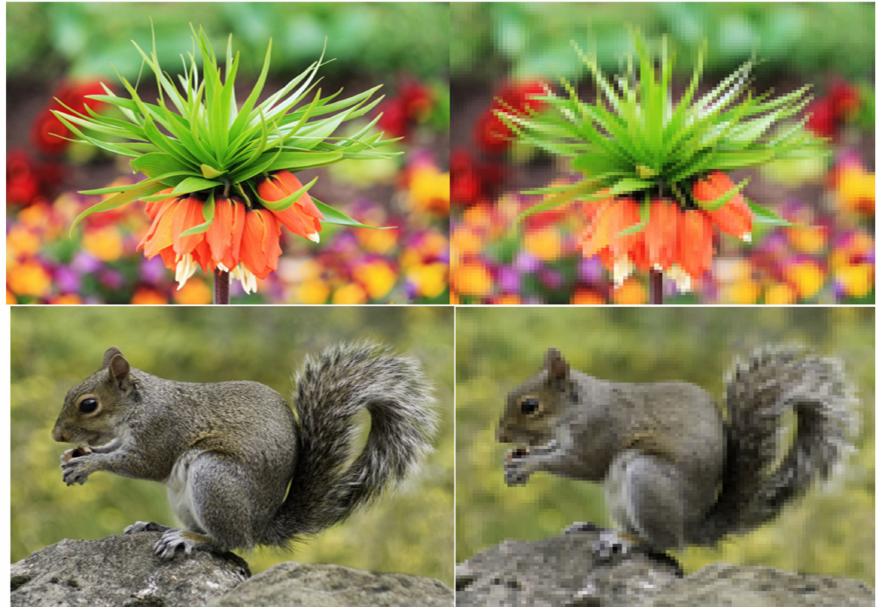
Figure 7. High-resolution and their lower-resolution images.